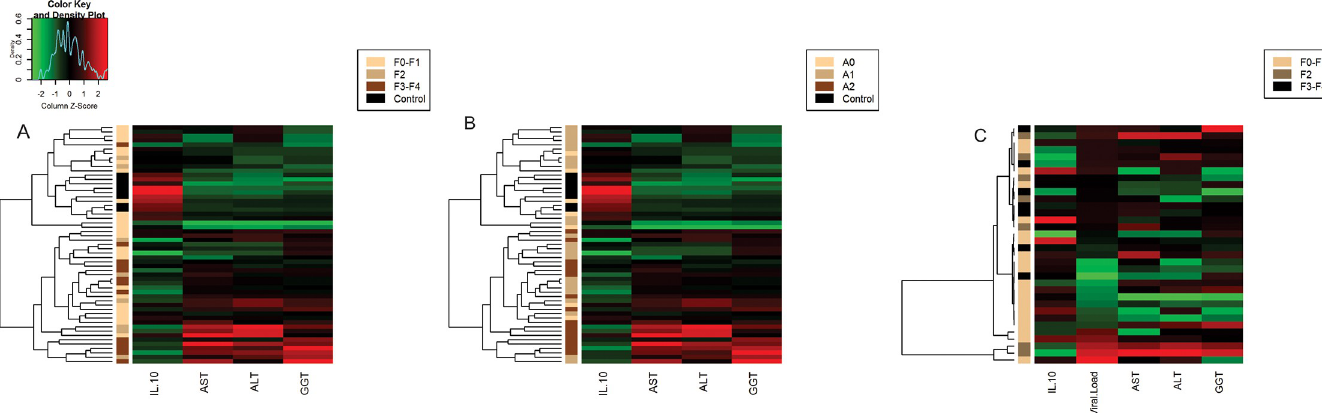
Fig 3. Analysis of IL10 mRNA levels according to the clinical condition of the liver and viral load represented by heatmaps. A-B: Intrahepatic IL10 expression showed a clear ability to cluster patients with low plasma ALT, AST and GGT concentrations and different METAVIR scores. C: Viral load was able to cluster patients with high plasma concentrations of liver enzymes, but intrahepatic IL10 expression was not able to cluster chronic liver disease patients with different liver fibrosis scores (METAVIR).